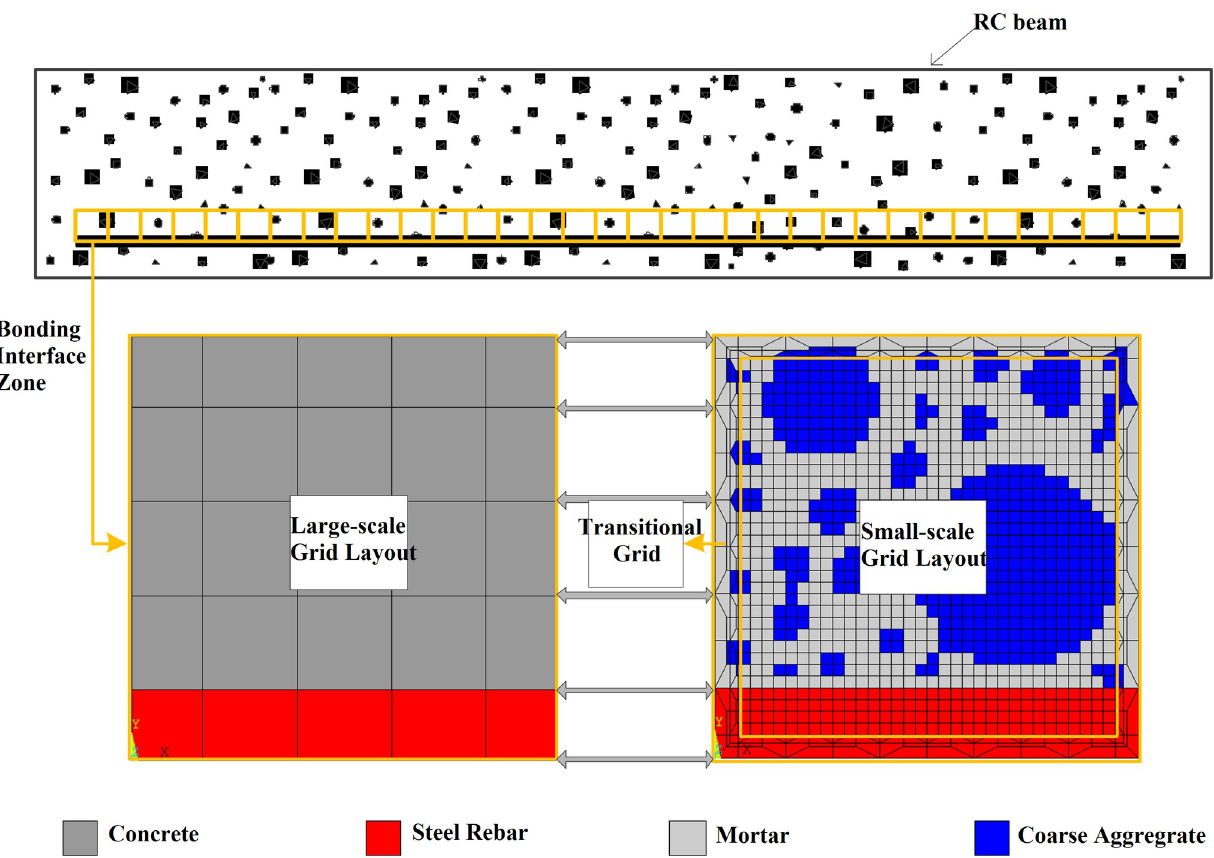
Fig 5. Diagram of concurrent multi-scale modeling of RC structure. The size of the local area is 36mm × 36mm, in which there are 25 grids in large-scale grid layout and 1296 grids in small-scale grid layout respectively.